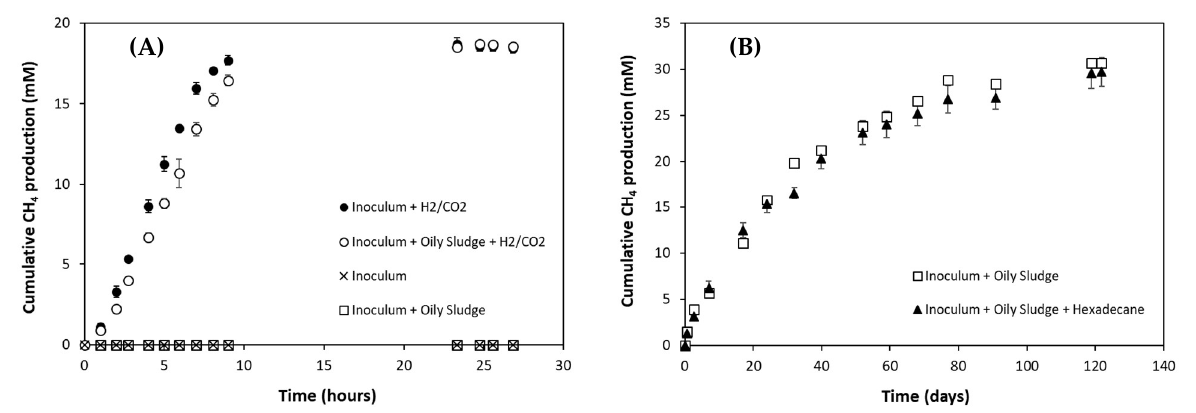
Figure 4. Cumulative methane production in the assays with H 2 /CO 2 ( A ) and during prolonged incubation of the sludge mixture (without H 2 /CO 2 ) ( B ). The results presented are the averages and standard deviations for triplicate assays.